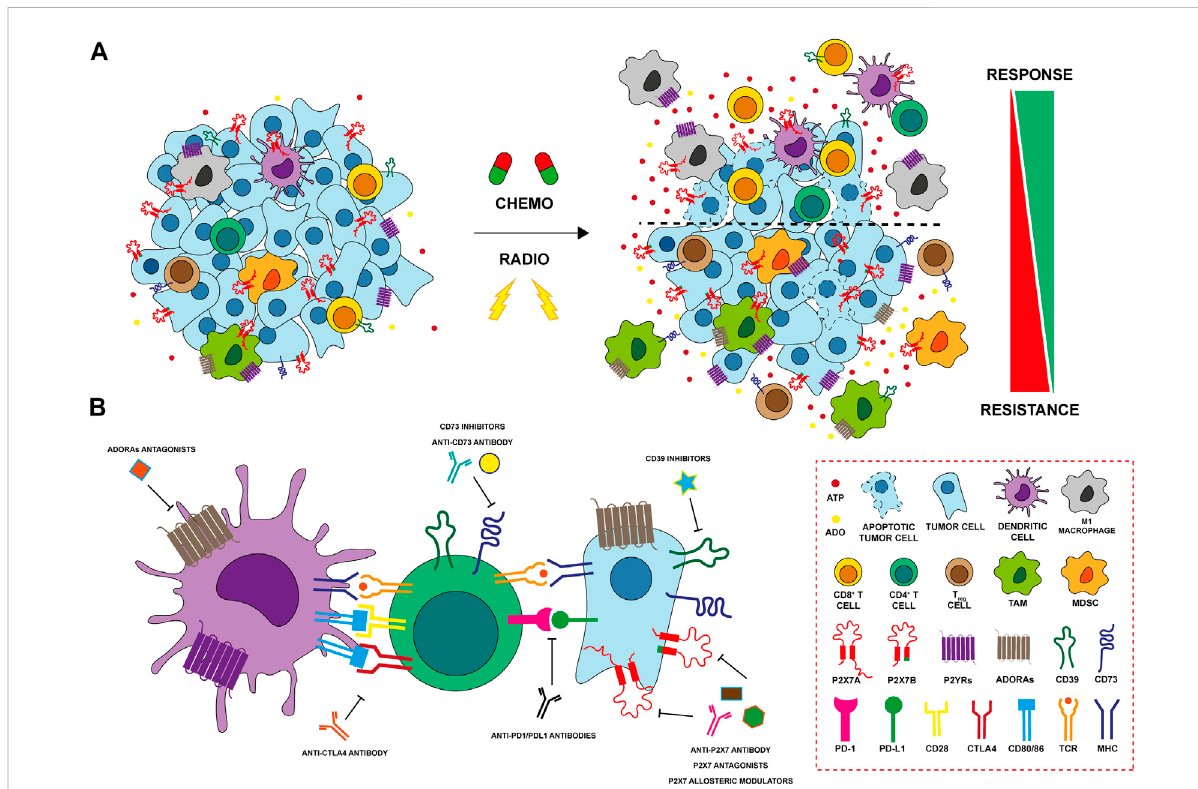
FIGURE 2 Modulationofpurinergicsignalingafteranti-tumoraltherpahy (A) Chemo-andradiationtherapy(RT)inducecelldeathandreleaseofATPinthe tumor microenvironment(TME). Cancer cells expressing P2X7A dieat a high ATP concentration, while those expressing the truncated P2X7B variant areprotectedandresponsibleoftumorrecurrence.P2YRsasP2Y 1 ,P2Y 2 ,P2Y 6 andP2Y 12 protectcancercellsconferringresistancetocytotoxicdrugs and potentiating cellular response to DNA damage induced by RT. ATP also exerts important effects on immune cells of the TME after therapy. ATP binds P2X and P2Y receptors on macrophages and dendritic cells (DCs) leading to their activation and release of in fl ammatory cytokines. Activated DCs increase CD4 + T helper cells and CD8 + T cytotoxic cell responses triggering an anti-tumour immune response. In contrast, increased expressionofectonucleotidasesCD39andCD73onbothcancerandimmunecellsleadstohydrolizationofATPtoADO,that,inturn,exertsapotent immunosuppressive activity further enhancing the recruitment of T reg and myeloid-derived suppressor cells (MDSCs). ADO activates adenosine receptors (ADORAs) A2A and A2B inhibiting antigen presentation exerted by DCs, promoting M2 macrophage differentiation and impairing CD8 + T cytotoxiclymphocytefunctions.Finally,bothchemotherapyandRTinducestheupregulationofADORAsinresistanttumorcellsthat,inturn,activate the multiple drug resistance protein-1 (MRP1) and induce stemness and EMT (B) P2X7, CD39 and CD73, and ADORAs can be targeted with different therapeutic approaches ( i.e. using antagonists, allosteric modulators or antibodies) in order to improve antitumor activity affecting both tumor and immune cells in the TME. The combination of immunocheckpoint inhibitors with therapies targeting purinergic signaling represents a promising effective therapeutic strategy in several cancers and it is currently under investigation in preclinical and clinical